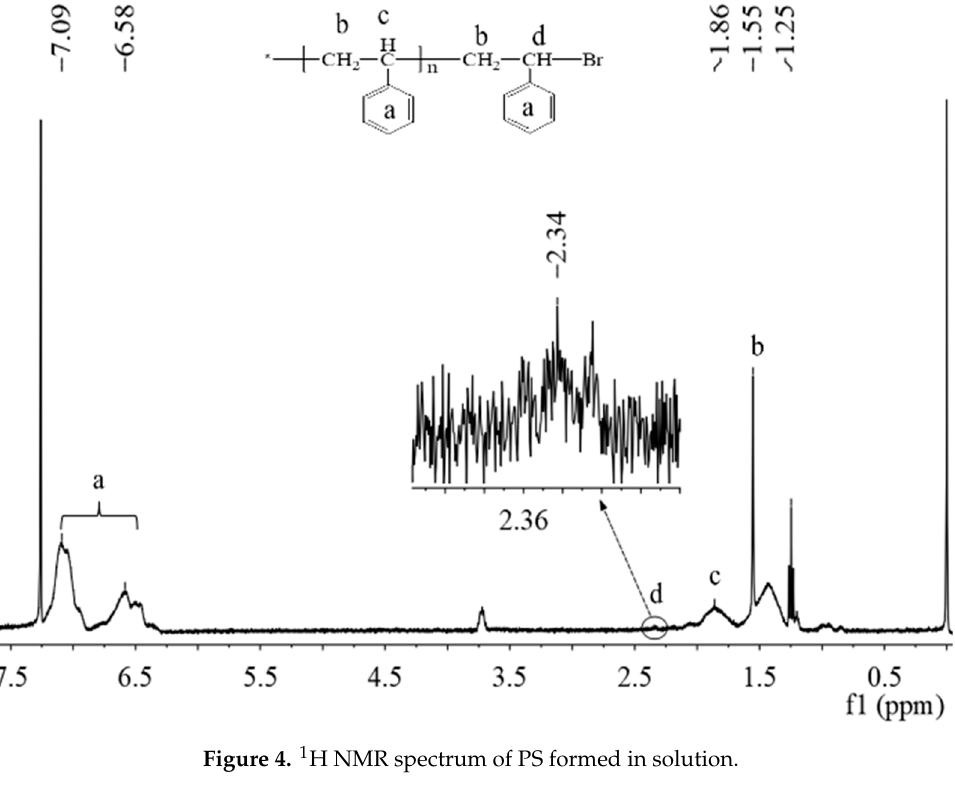
Figure 4. 1 H NMR spectrum of PS formed in solution.